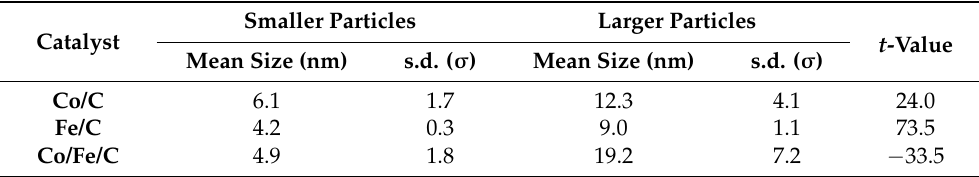
Table 3. Comparing particle size distribution in used catalyst samples by a t -test. Catalyst